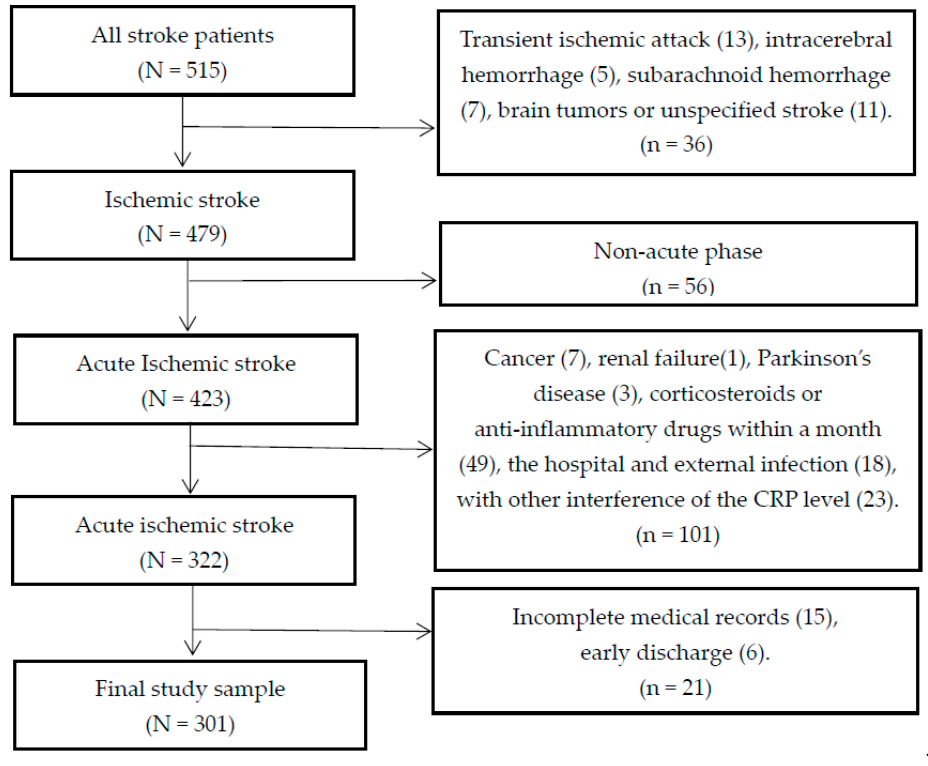
Figure 1. Flow chart in the selection of study patients.